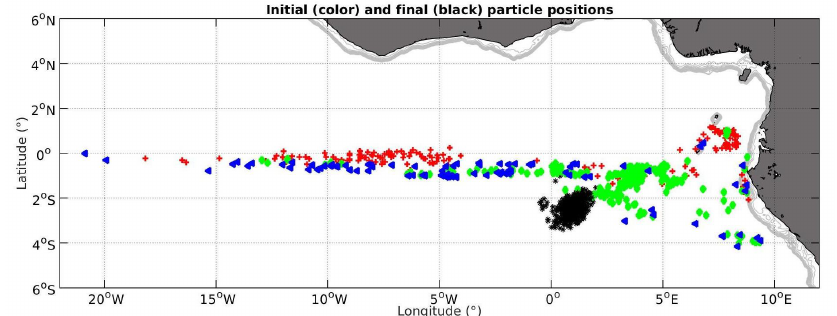
Figure 14. Initial (3 January = day 3) and final (10 May = day 131) positions of all particles constituting the vortex core. The initial position is identified by the colored symbols red + for particles with high initial PV values, blue (cid:47) for particles with low initial PV values and green (cid:5) for particles with weak variations between initial and final PV values. The final positions are identified by black ∗ . The thick black line represents the coastline of the model and thin gray lines are isolines of the water depth, from 50 to 500